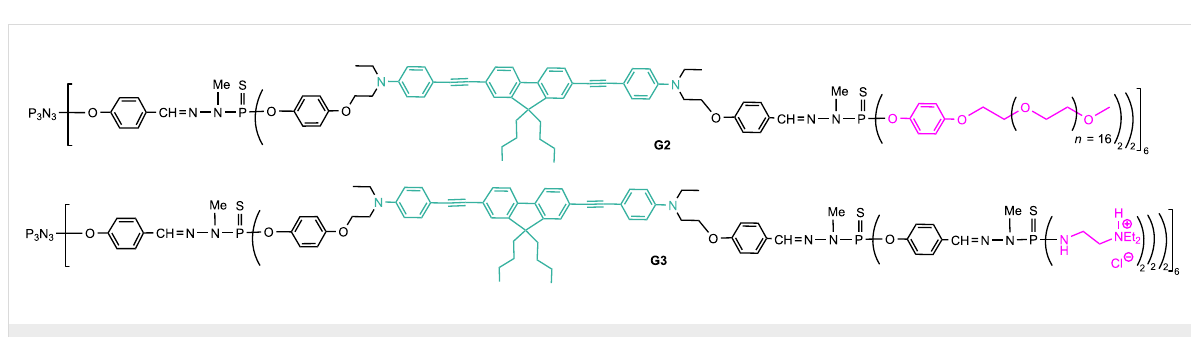
generation G2 than by the ammonium groups of the third gener- ation G3 as indicated by the quantum yields Φ f = 0.24 (G3 am- monium) and 0.39 (G2 PEG). However, the TPA cross-section measurements gave σ 2 max = 13,600 GM for G3 ammonium, and 8,400 GM for G2 PEG. Thus, both compounds exhibit similar performances, the lower quantum yield being counter-balanced by a higher TPA cross-section, and vice versa